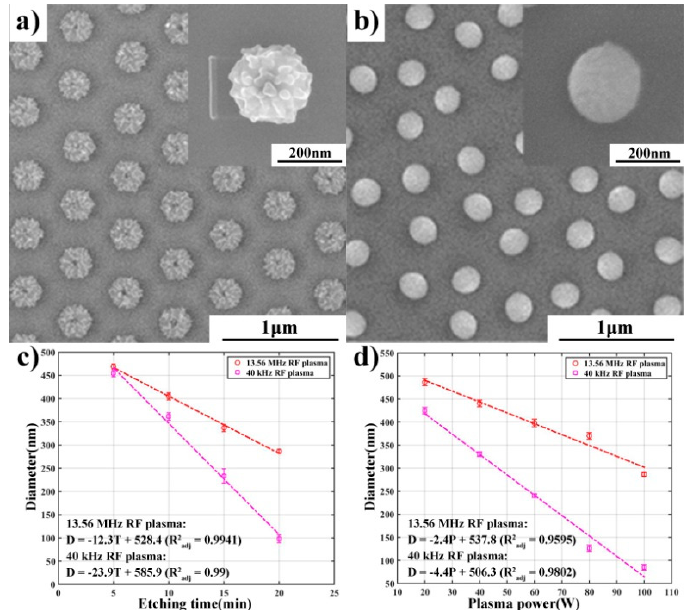
Figure 2. Comparison of the morphologies of PS nano-spheres etched by the plasma etching systems with different working frequencies. SEM images of the PS nano-spheres etched with the ( a ) 13.56 MHz and ( b ) 40 kHz plasma system, respectively. ( c ) PS nano-sphere size as a function of etching time. ( d ) PS nano-sphere size as a function of etching power. The etching time was kept at a constant of 20 min.